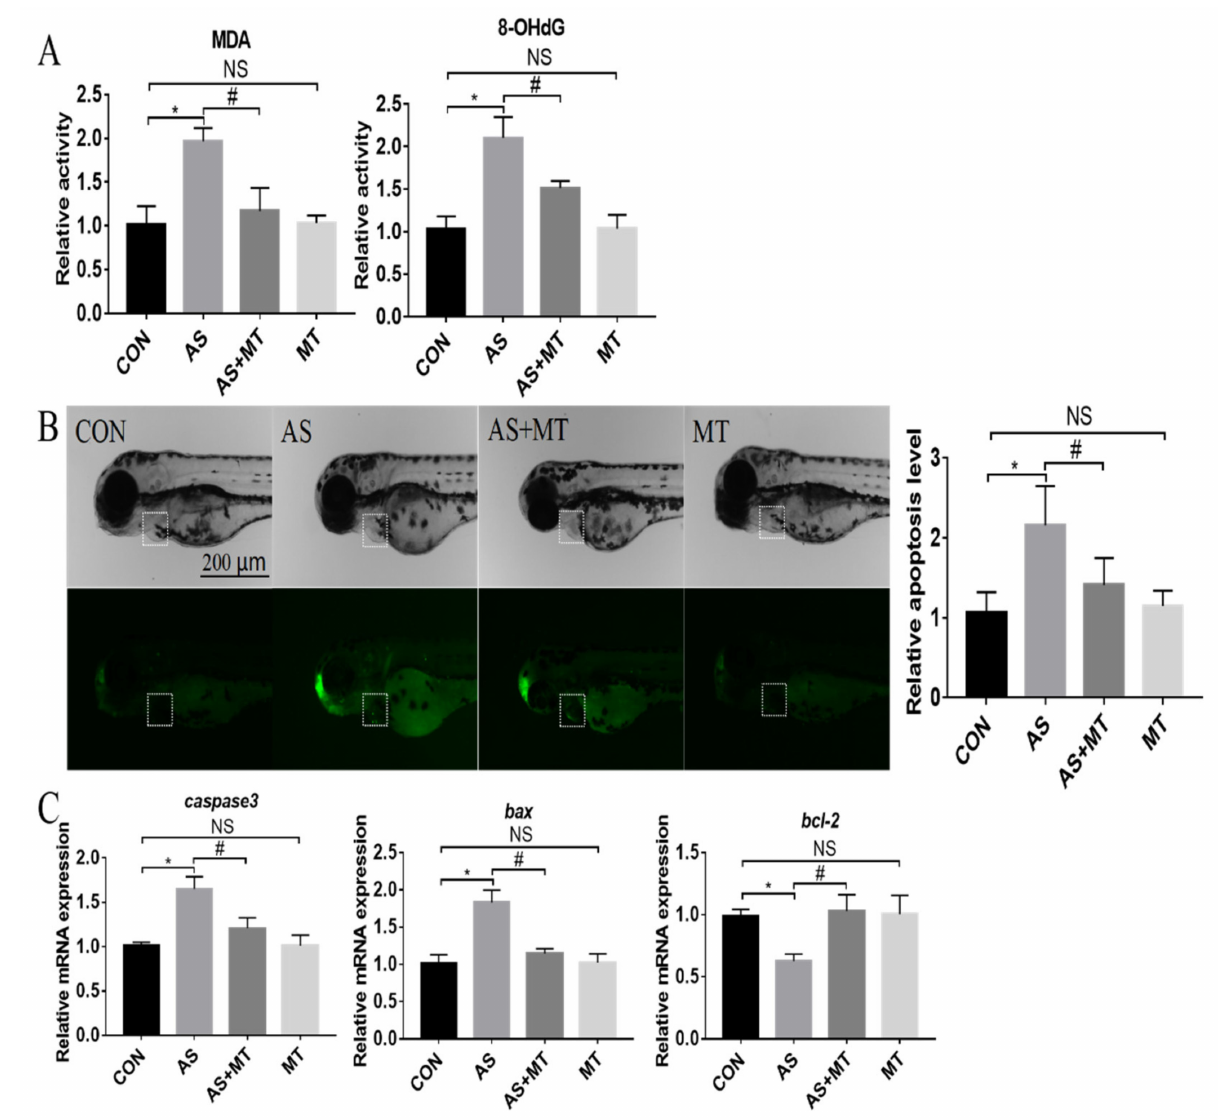
Figure 3. The effects of melatonin on the NaAsO 2 -induced oxidative damage and apoptosis changes in zebrafish embryos at 72 hpf. ( A ) Oxidative damage in zebrafish embryos. ( B ) Representative images stained by AO and the quantification of apoptosis signals in heart area. Heart regions are represented by the dotted squares. ( C ) Relative expression levels of apoptosis-related genes. CON: system water as the vehicle control; AS: NaAsO 2 at 1.0 mM; MT − 9 : Melatonin at 10 − 9 M. * p < 0.05, compared to CON; # p < 0.05, compared to MT; NS, compared to